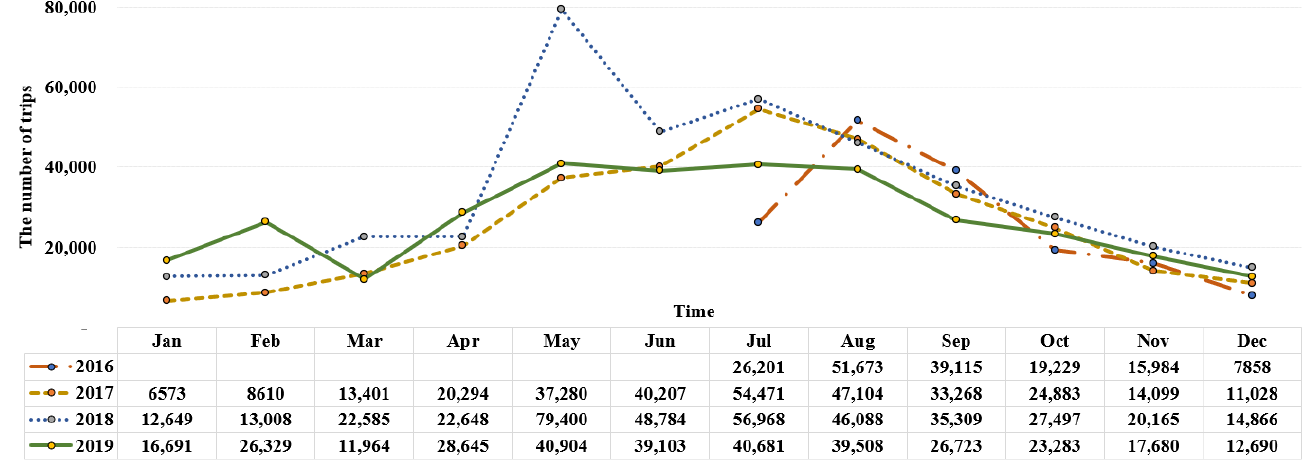
Figure 5. Biketown ridership by months and years (Data source: https://www.biketownpdx.com/system-data) (accessed on 10 June 2022).